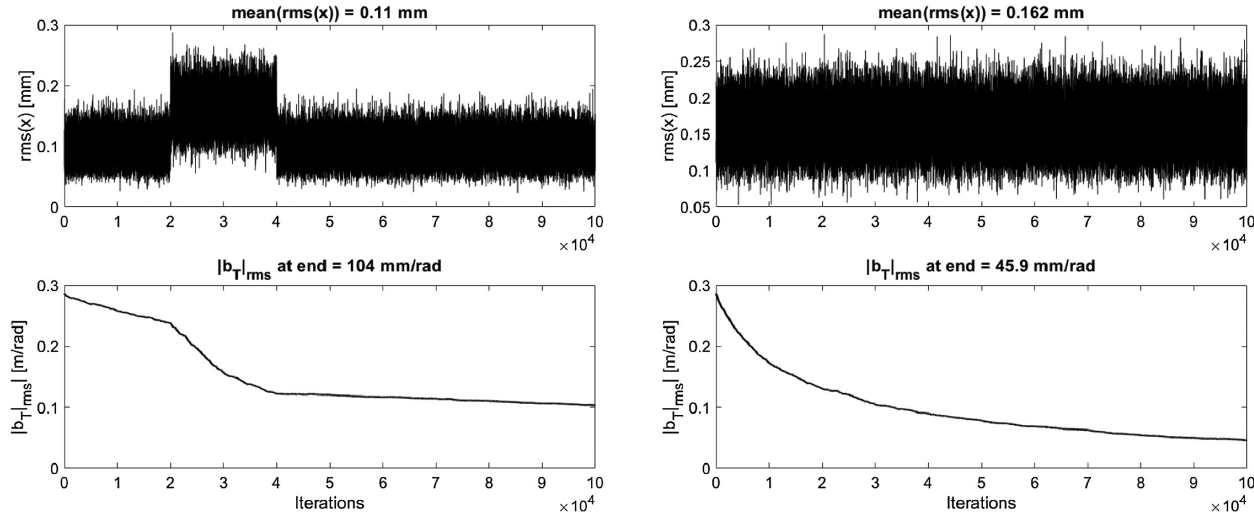
FIG. 4. Simulations based on parameters used for Fig. 2. Left: round-robin dithering with 20 μ rad active from 20000 to 40000 iterations, which temporarily increases the rms orbit σ x but significantly helps to reduce the discrepancy j b rms j . Right: dithering with the same parameters is active all the time, which increases σ x all the time, but reduces j b rms j even